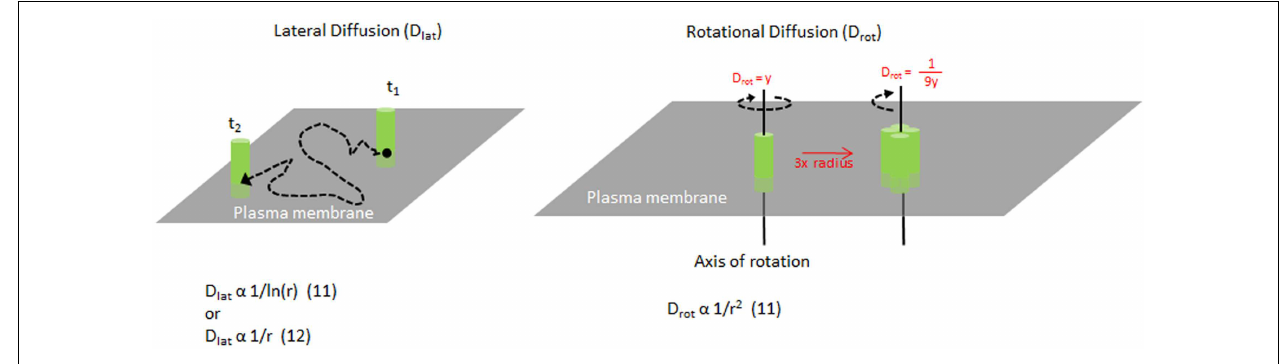
of the molecule and their diffusion rates are shown for each motion. For example, increasing the radius of a complex to 3 × will change the D rot by 1/9 × .